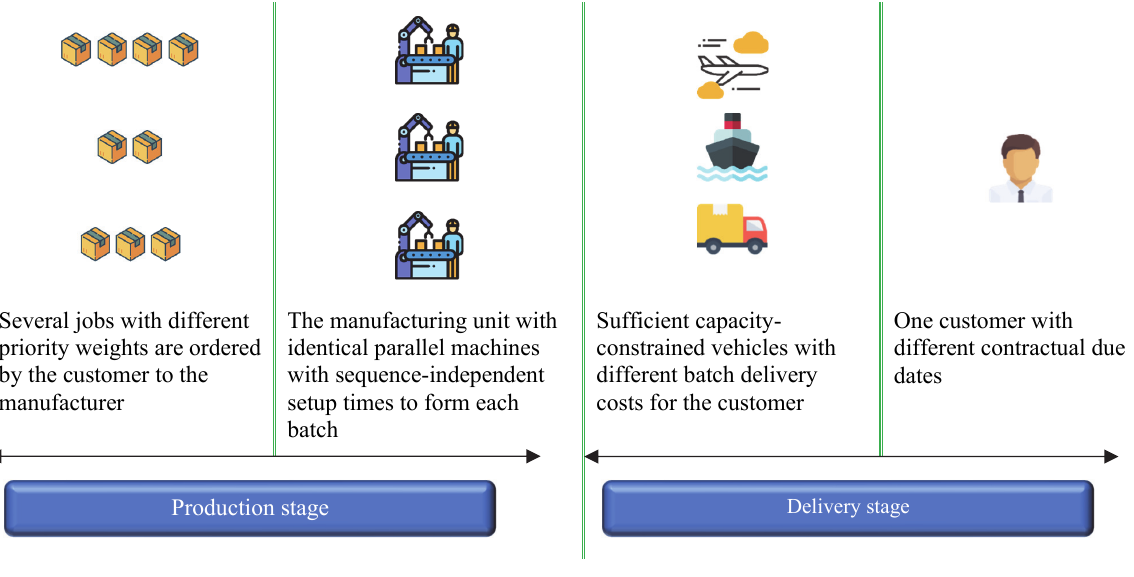
Fig. 1. The problem schematic